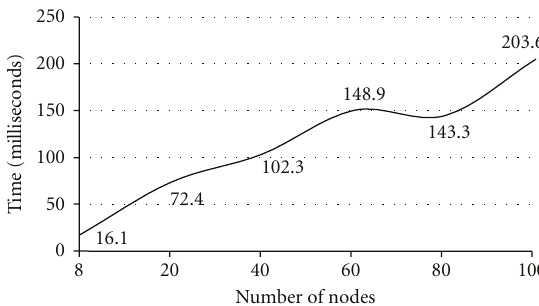
Figure 6: Binary tree construction timings. Figure 7: Certificate exchange timings (network